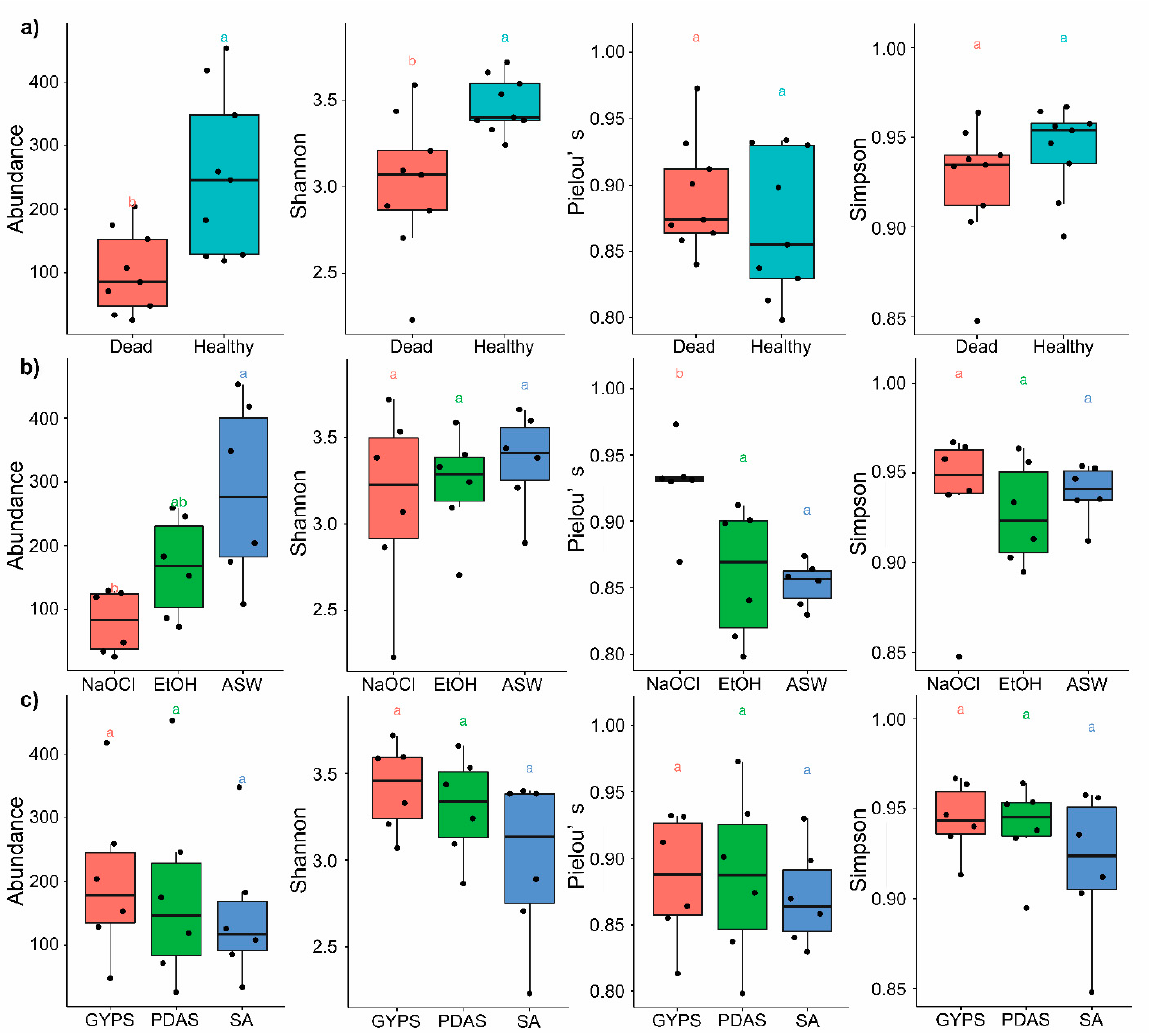
Figure 4. Box plot of alpha diversity indices Shannon, Pielou’s, Simpson, and the relative abundance derived from different conditions of Pterocladiella capillacea . The Wilcoxon test was used to determine the significance level between the different groups, while the Kruskal–Wallis test was used to calculate the significance level among the following: ( a ) healthy and dead thalli; ( b ) thalli surface sterilized/washed by artificial seawater (ASW), 70% ethanol (EtOH), and 4% sodium hypochlorite (NaOCl); and ( c ) thalli plated on seawater agar (SA), glucose-yeast extract-peptone seawater agar (GYPS), and potato dextrose seawater agar (PDAS). a, b = same letters indicate no significant differences at p < 0.05.